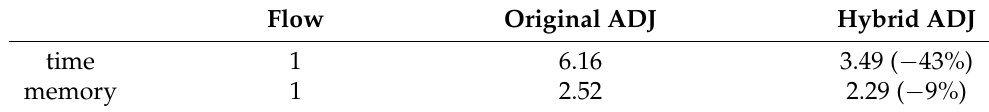
Figure 15. RMS residual convergence histories of both the flow and adjoint solvers ( a ); Comparison of CPU time among different solvers for the NASA Stage 35 ( b ). Table 2. Comparison of time and memory consumption among different solvers for the NASA Stage